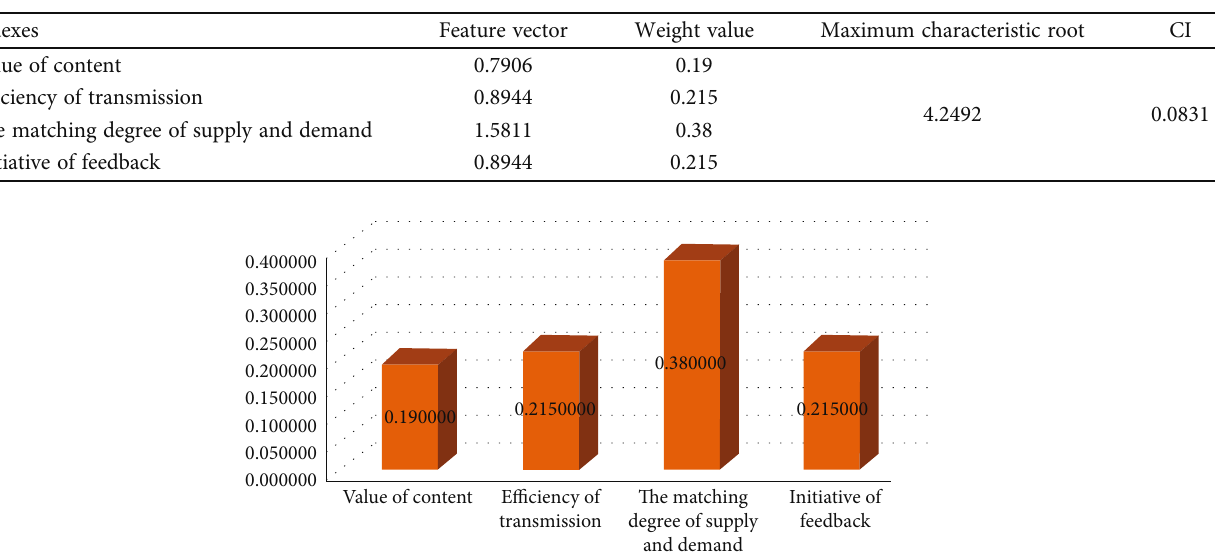
Table 3: Results of AHP.